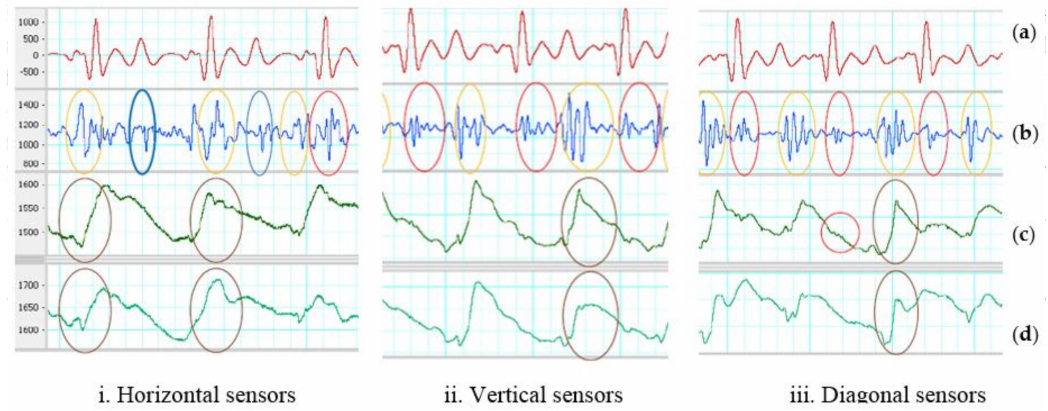
Figure 7. SUBTRACTOR on walking motion. ( a ) Filtered ECG (5–20 Hz). ( b ) Filtered SCG (20–50 Hz). Red oval indicates identified systoles. Blue oval indicates detected diastoles. ( c ) First sensor z-axis. Red circle indicates a small SCG signal, brown ovals show high-energy portion of walking. ( d ) Second sensor z-axis. Brown ovals indicate high-energy portion of walking.